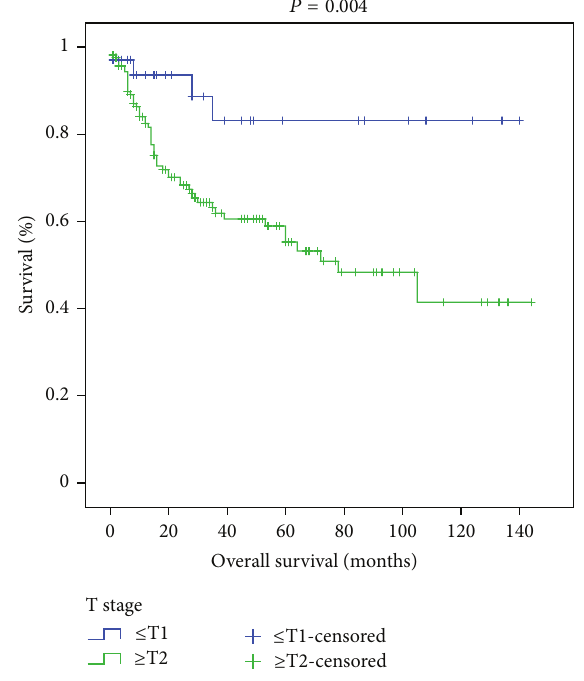
Figure 2: The Kaplan-Meier curves according to T stage ( 𝑃 = 0.004